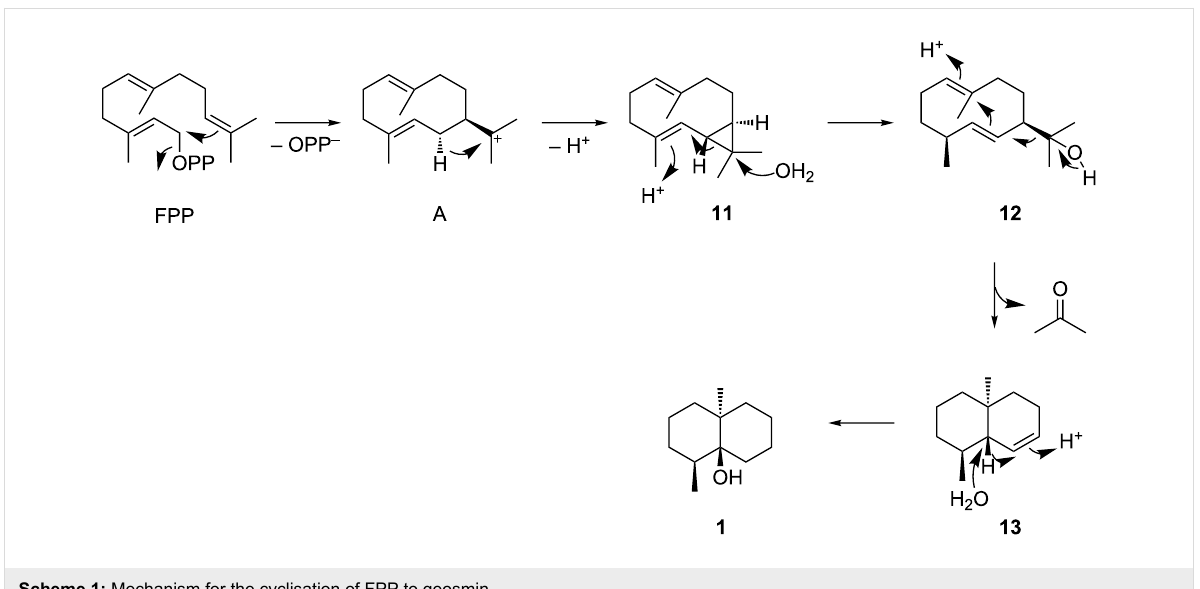
Scheme 1: Mechanism for the cyclisation of FPP to geosmin.